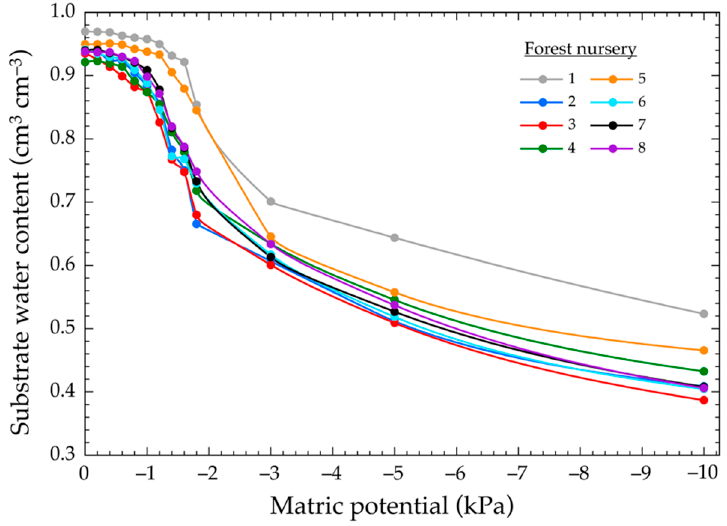
Figure 4. Water release curves of substrates from sampled forest nurseries after potting. Table 2. Physical properties of substrates from eight forest nurseries after